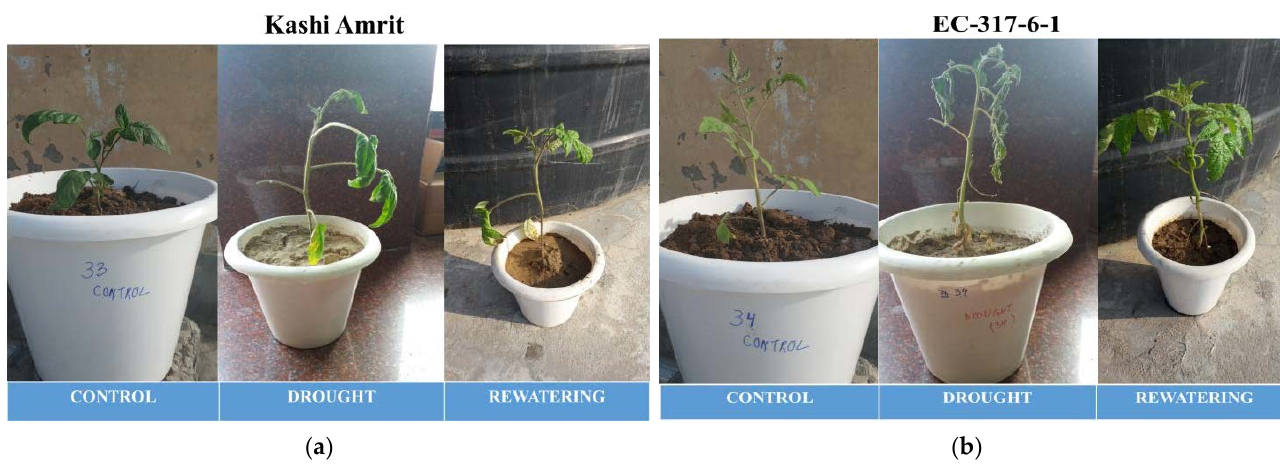
Figure 7. In vivo phenotyping of early detection of drought in tomato genotypes Kashi Amrit ( a ) and EC-317-6-1 ( b ) under normal, drought and rewatering conditions.